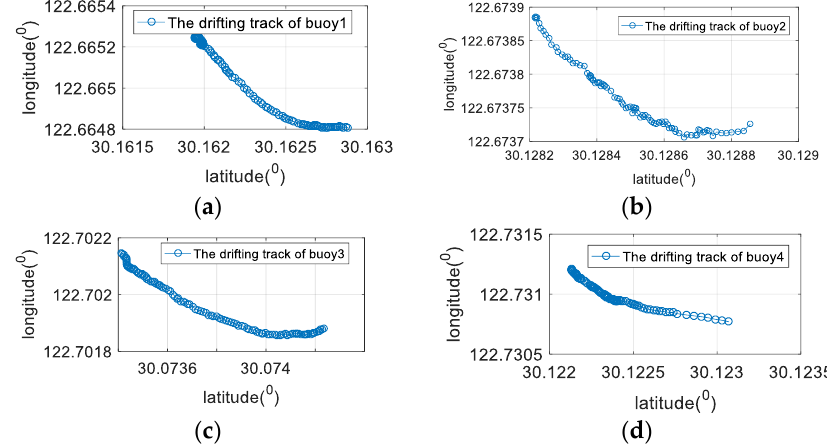
Figure 12. Sea trial conditions. ( a ) The sea trial sound velocity profile; ( b ) the movement trajectory of the AUV and the position of the buoy beacons.